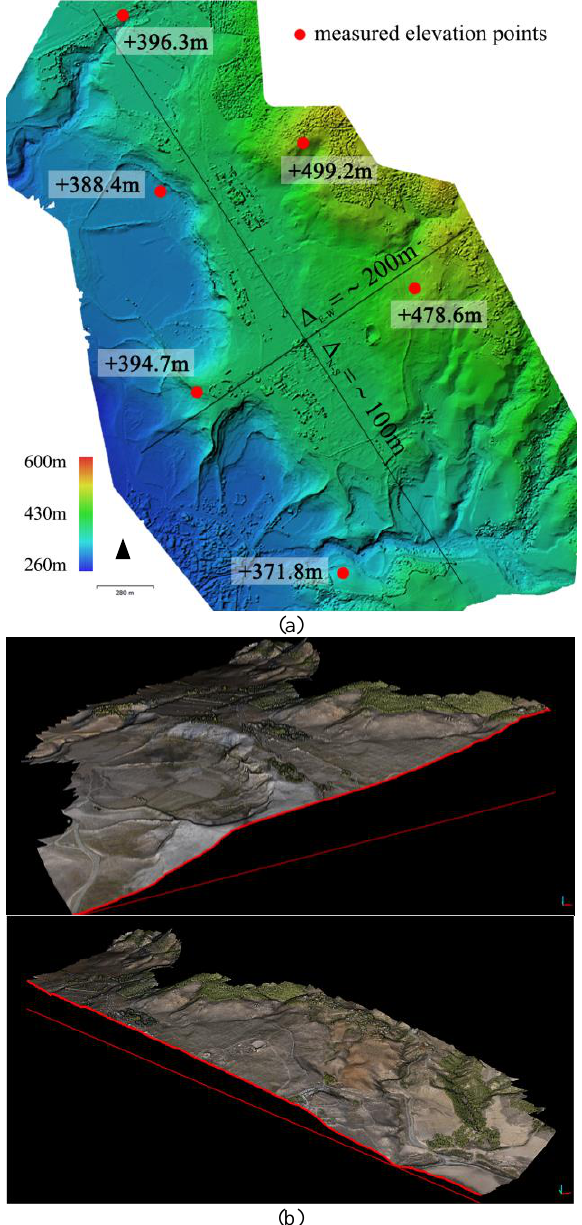
Figure 3. (a) The morphological characterization of the site with large differences in height towards the limestone hill, according the two main longitudinal and transverse section, reported in (b).